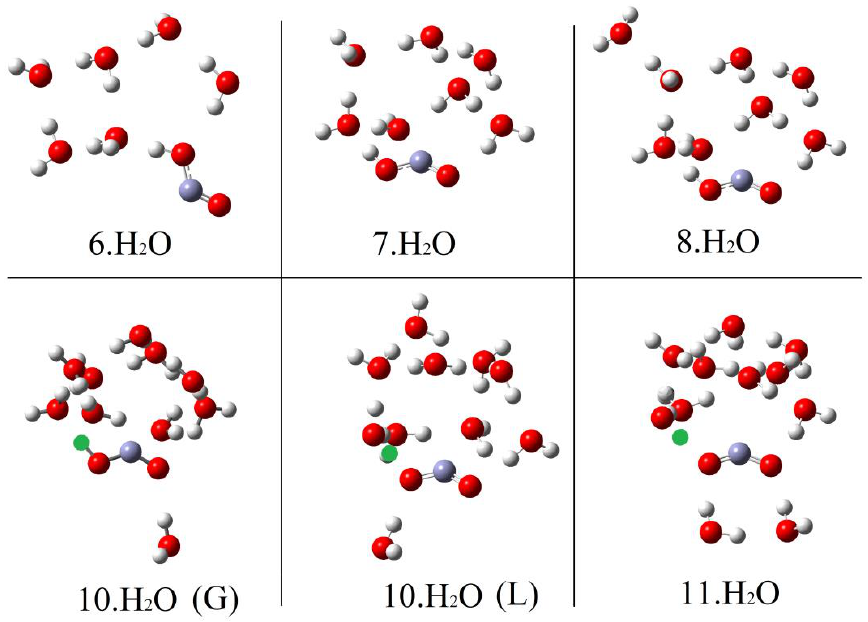
Figure 3. Optimized Cluster Structures of trans -Carboxyl ( 1Ht ) with 6 to 11 H 2 O molecules. Departing proton shown in green.